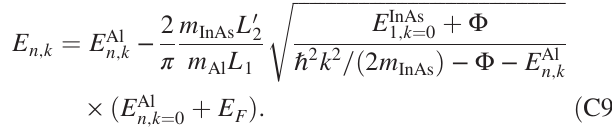
Figs. 11(a) and 11(b) we show details for the n ¼ n